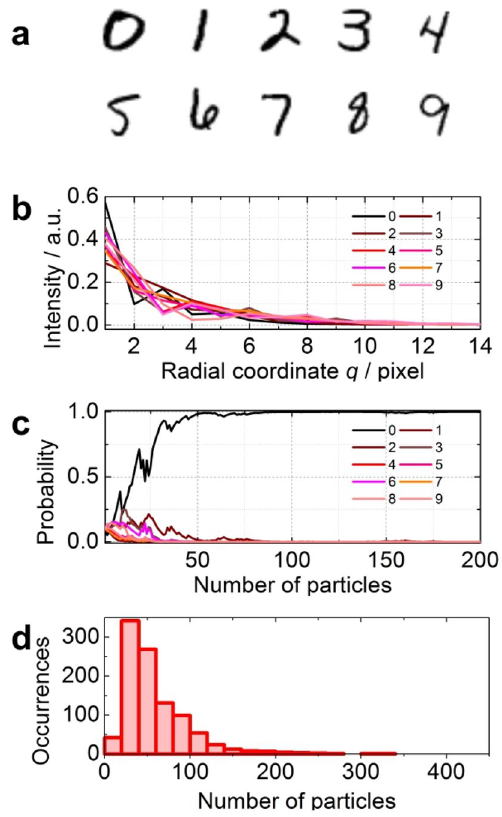
Figure 2. Principle of low-dose diffraction recognition imaging. ( a ) Ten samples constituting the then hypotheses. ( b ) 1D PDF profiles corresponding to the diffraction patterns of each sample. ( c ) Evolution of probabilities as a function of number of detected particles. ( d ) Number of particles required to achieve 95% probability that the sample structure hypothesis is correct; results of 1000